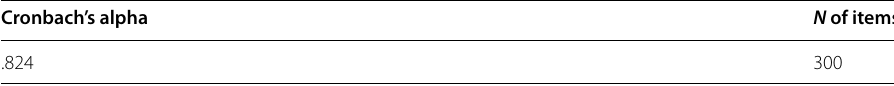
Table 4 Reliability statistics of the CEP